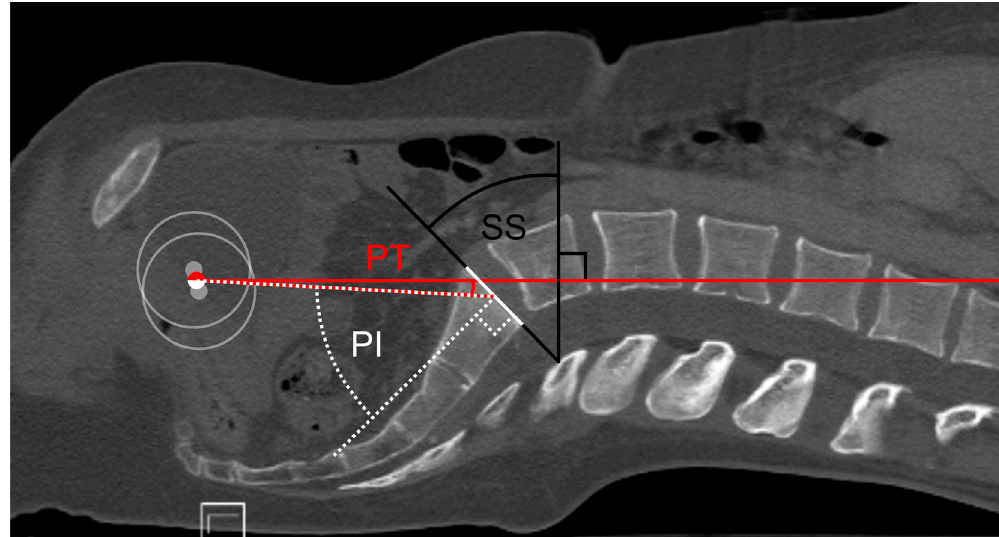
Figure 1. Measurement of the spino-pelvic parameters. The head of both femurs (grey circles) and their mean is marked with a white/red circle. A horizontal red solid line is drawn crossing the mean of the femur heads. The cranial endplate of the first sacral vertebra is highlighted with a white solid line. The pelvic tilt (PT) was measured as the angle between the red horizontal line and the white/red dotted line between the mean of the femur heads and the center of the cranial endplate of S1. The angle of the pelvic incidence (PI) was measured as the angle between the white/red dotted line between the mean of the femur heads and the center of the cranial endplate of S1, perpendicular to the midpoint of the cranial endplate of S1 (white dotted line). The sacral slope (SS) was measured as the angle between the cranial endplate of S1 perpendicular to the horizontal red solid line, highlighted with black solid lines.